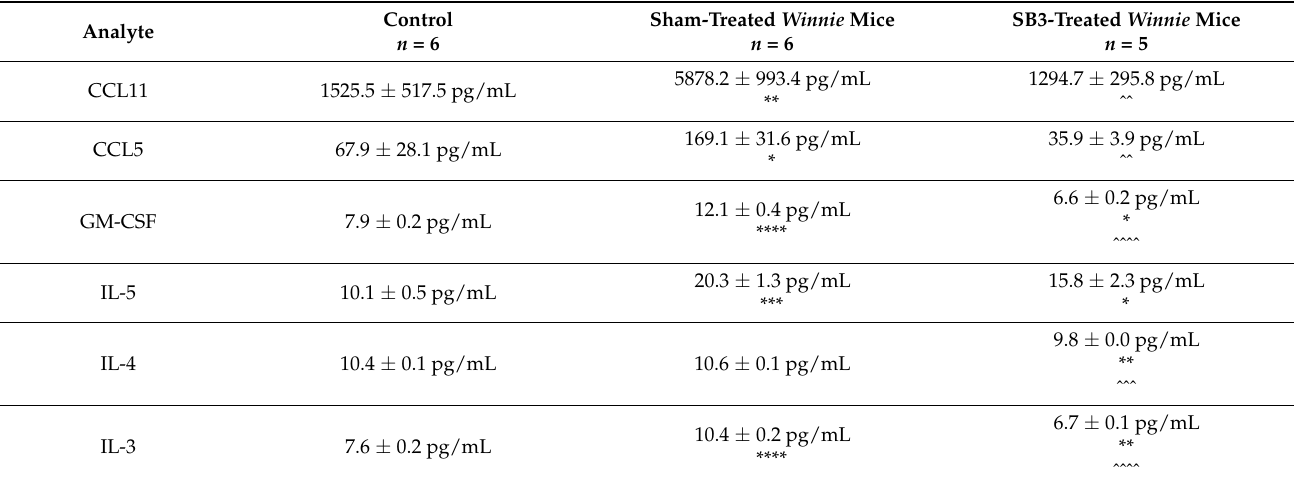
Table 3. Eosinophil-associated chemokines and cytokines in blood